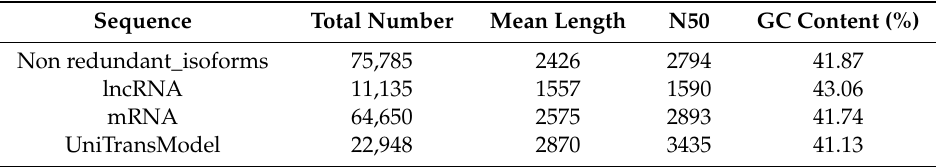
Table 1. Scutellaria baicalensis